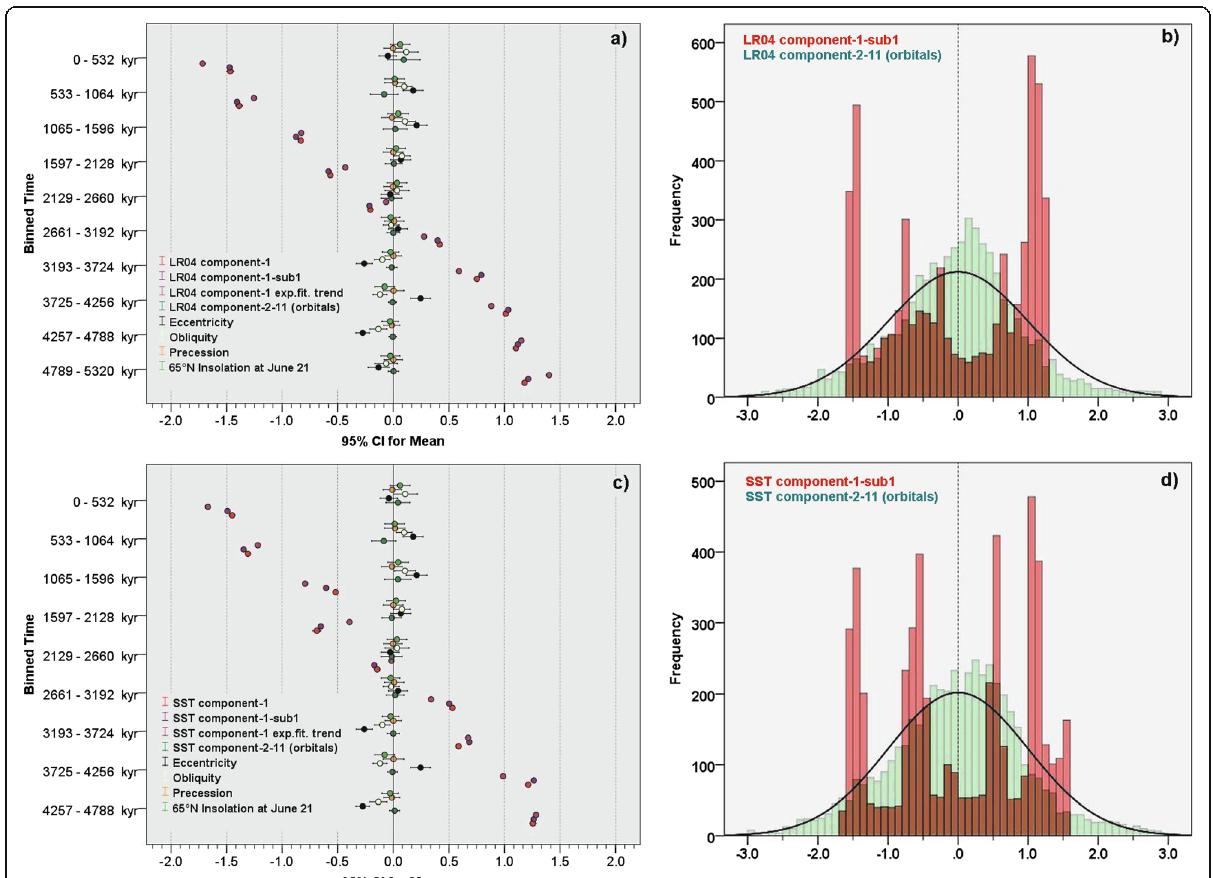
al. 1993), binned at 532-kyr constant time intervals. Overlapped histograms of b Plio-Pleistocene δ 18 O and d SST orbital component-2-11 vs. trend component-1 subcomp-1. The averages of the astronomical components oscillate around the standardized mean with little statistically significance differences and a roughly normal distribution. Instead, the averages of the trend components differ very significantly, deviating markedly from the mean with a general multimodal distribution. Data standardized on the entire Plio-Pleistocene record (mean = 0, standard deviation = 1) and, where necessary, inverted to have the same paleoclimatic polarity (positive values for positive forcing and